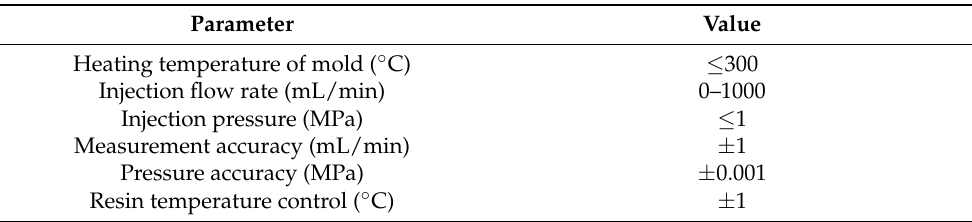
Figure 5. Experimental platform for dual-scale infiltration of in situ injection molding. Table 1. Main technical parameters of in situ injection molding dual-scale infiltration experimental platform.